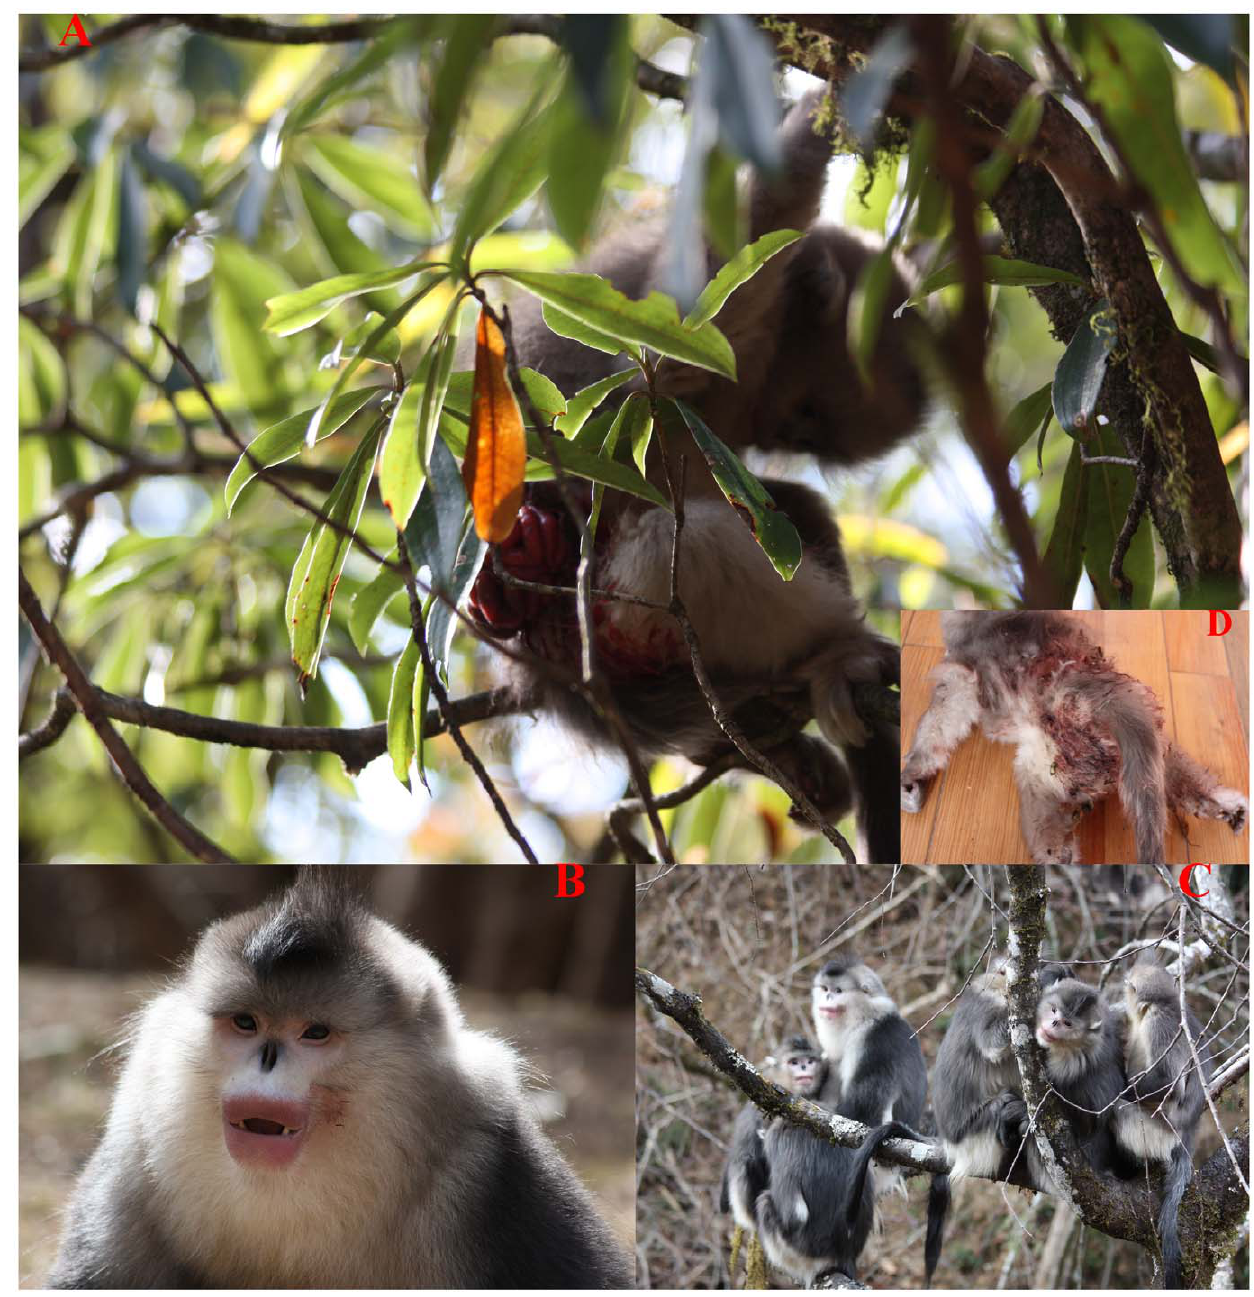
Figure 1. An OMU takeover of Rhinopithecusbieti occurred on Dec. 4, 2009. The invading male (B: dry blood on his left cheek) killed the eight-month-old infant (A) at 13:00 on Dec. 31, and the mother sexually solicited the invading male at 14:30. All members of the OMU flocked together (C) in the same tree thereafter. (D) Corpse of the killed infant.